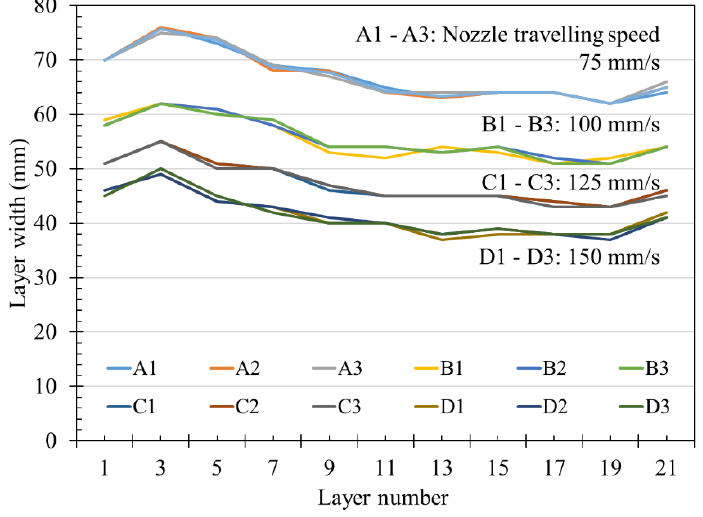
Figure 12. Dependence of layer width on printing cycle at the measured locations.